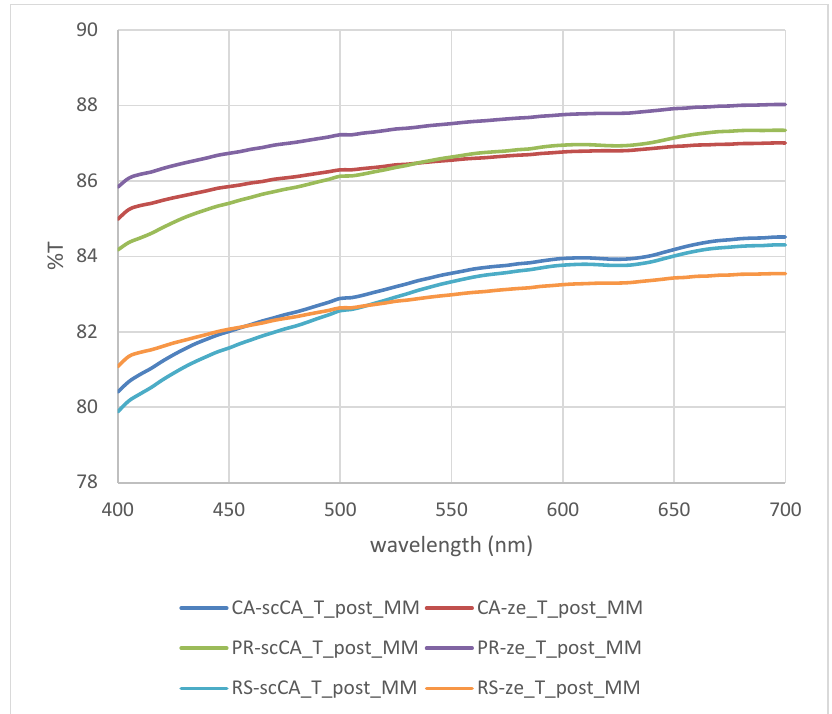
Figure 5. Transmittance curves of all aligners at T1 without SD for better visual clarity.